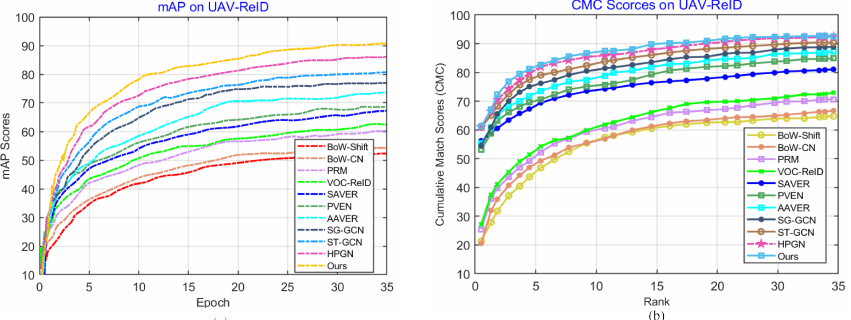
Figure 5. The mAP and CMC curve comparison of our method and several state-of-the-art approaches on UAV-ReID dataset. ( a ) mAP curve comparison on the UAV-ReID; ( b ) CMC curve comparison on the